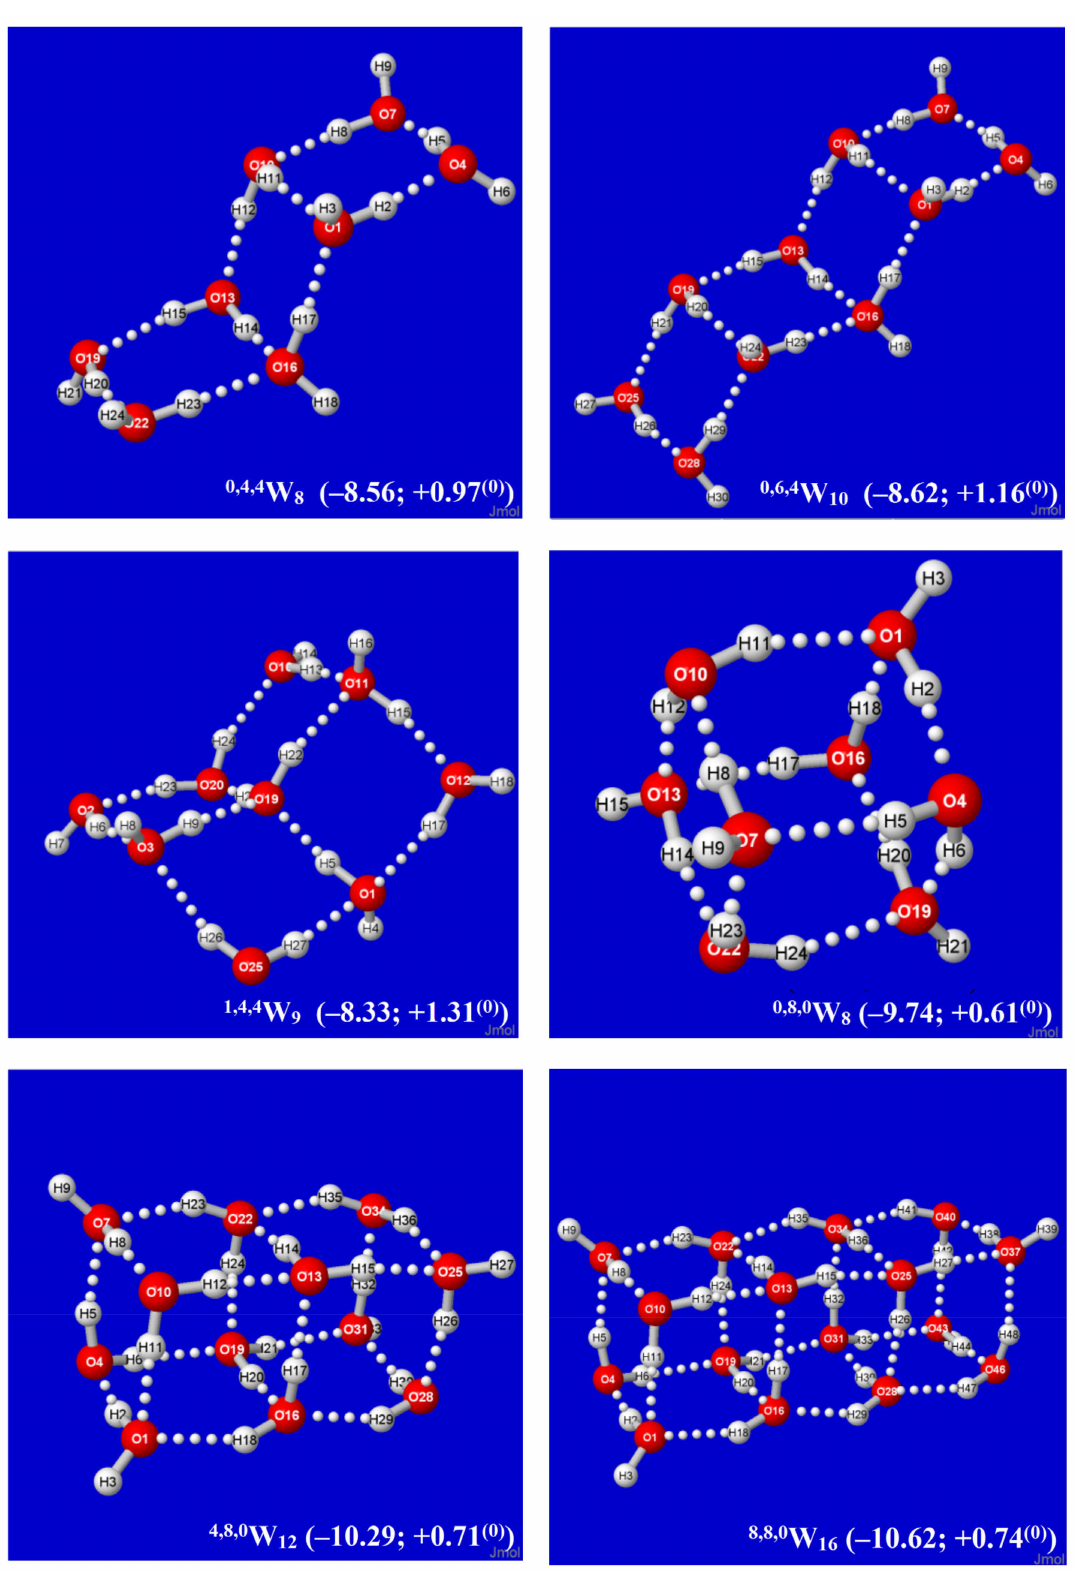
Figure 2. Calculated Aufbau sequence of windowpane clusters q,t,d W k from starting cyclic tetramer 0,0,4 W 4 ( upper left ), showing parenthesized per-monomer changes (kcal/mol) in energy ( Gibbs free energy ( ∆ G (0) ) from free water molecules in each